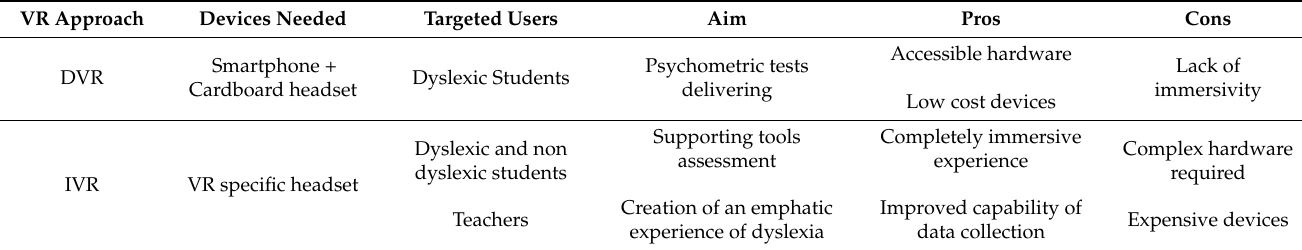
Table 1. Use of the two VR approaches (DVR and IVR) within